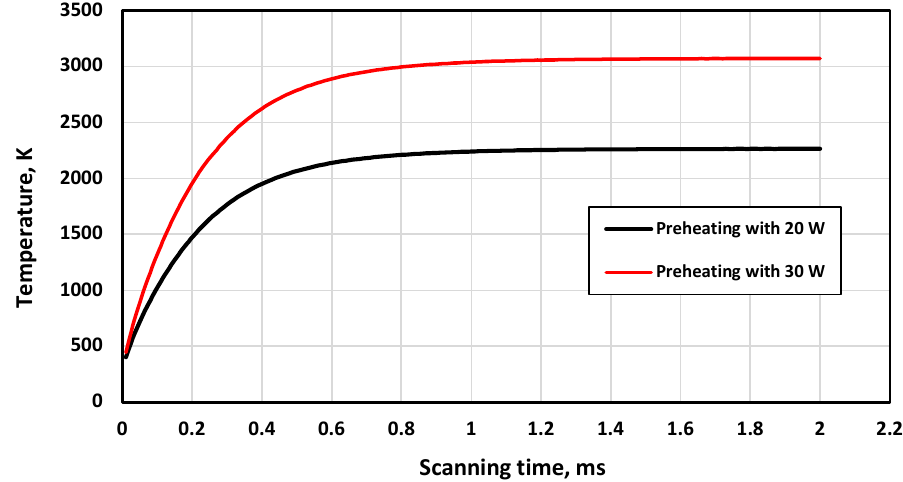
Figure 10. Temperature history for the preheating laser source using different power.